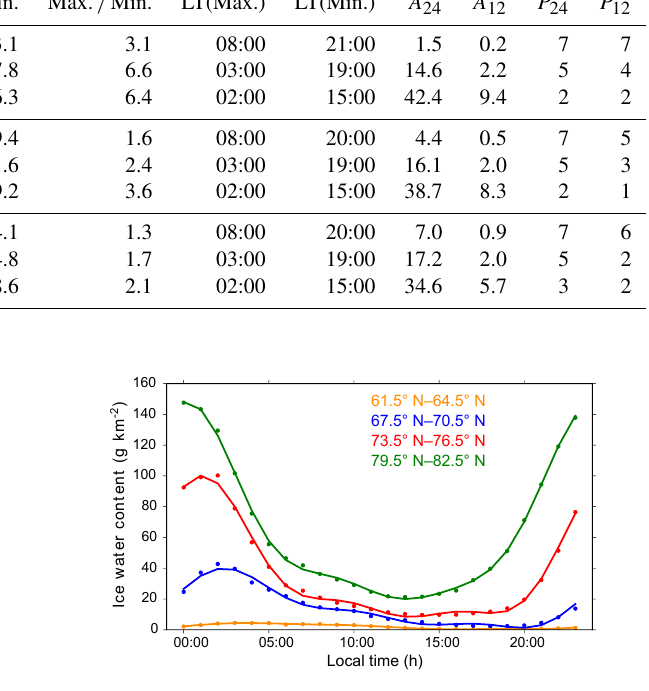
Figure 9. Diurnal variation of hourly median IWC values for July 2007–2013 for different latitude bands. No threshold has been ap- plied, IWC values of zero (no PMCs) are included. Dots indicate the data and solid lines are harmonic fits using periods of 24, 12, and